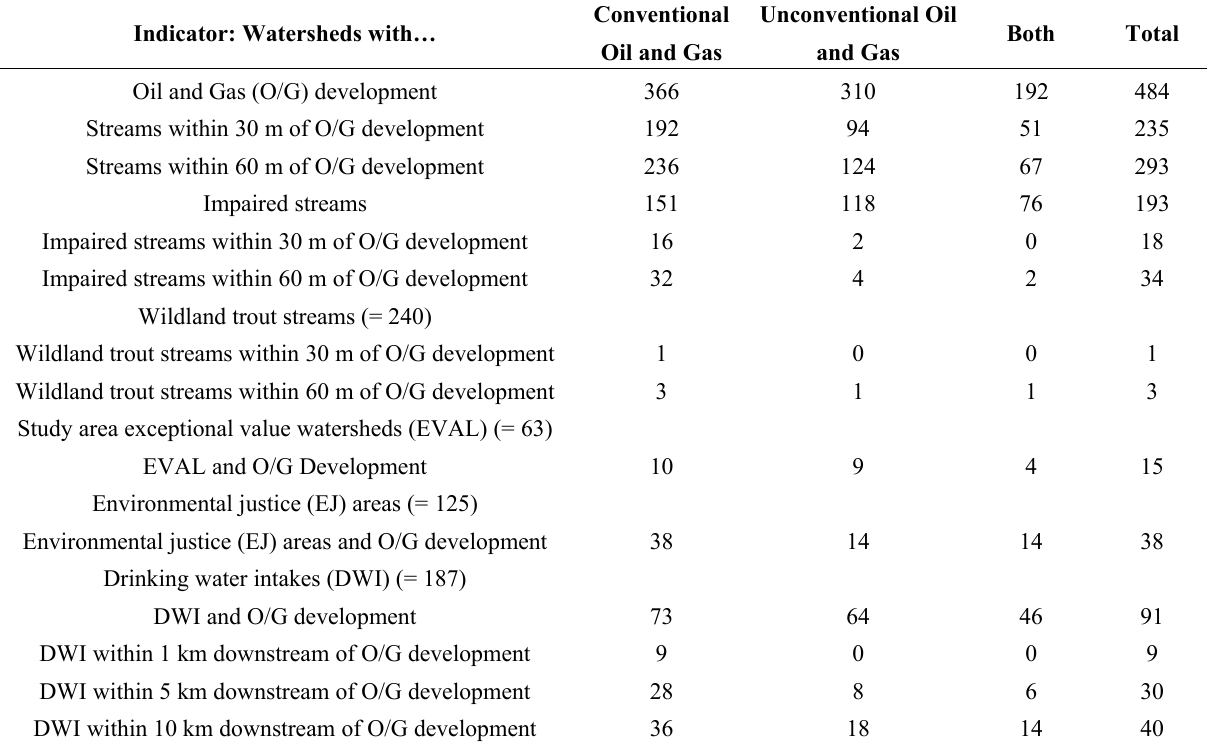
Table 3. Oil and gas development in relation to watershed resources. There are 930 12-digit watersheds in the study area and 484 with oil and gas development. Values in the column labeled “both” identifies where unconventional and conventional co-occur in the same watershed, and the column labeled “total” identifies where either or both activities co-occur. Conventional Unconventional Oil Indicator: Watersheds with… Oil and Gas and Gas Oil and Gas (O/G) development